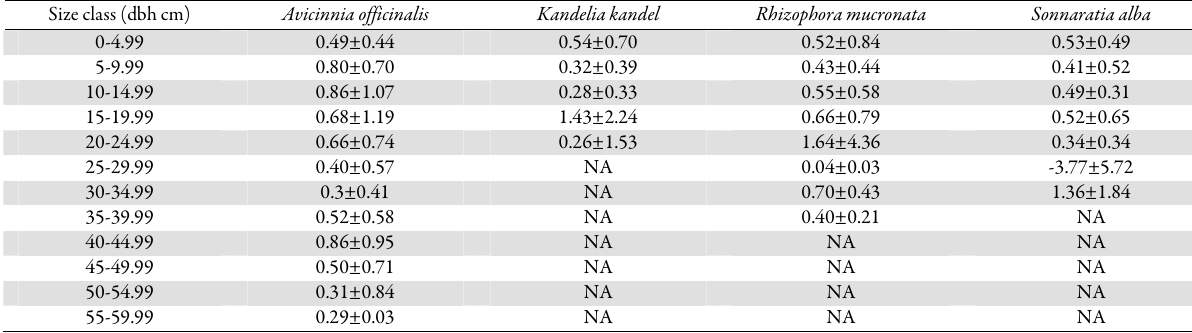
Tab. 4. Mean growth rates (± SD) (cm) in various size classes for different species in Kagekanu permanent vegetation plot Size class (dbh cm)